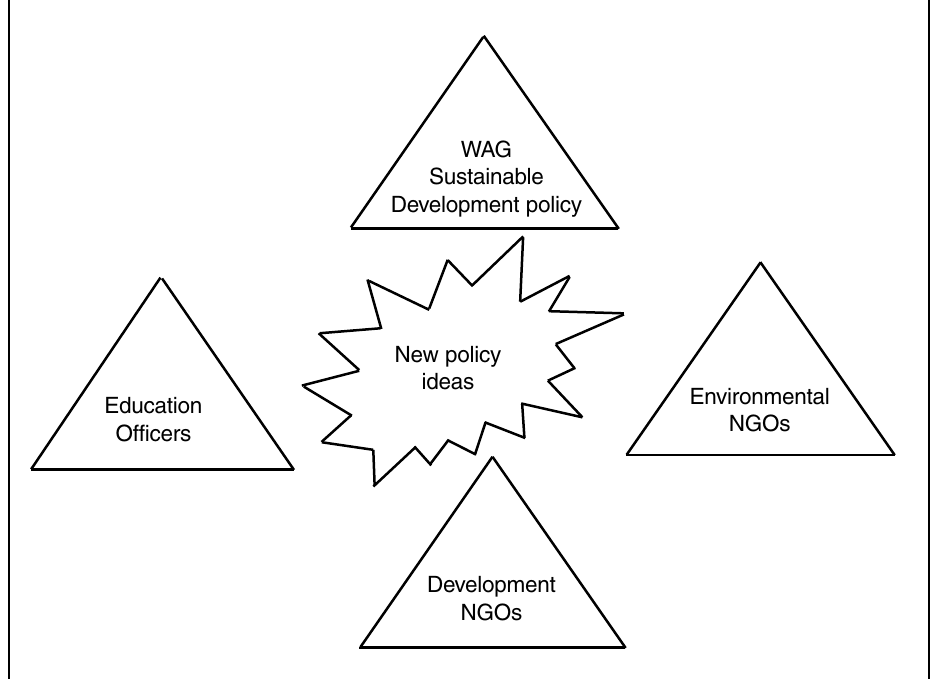
Figure 1: Groups in the early stages of ESDGC development as depicted by Level 3 Activity Theory after Russell